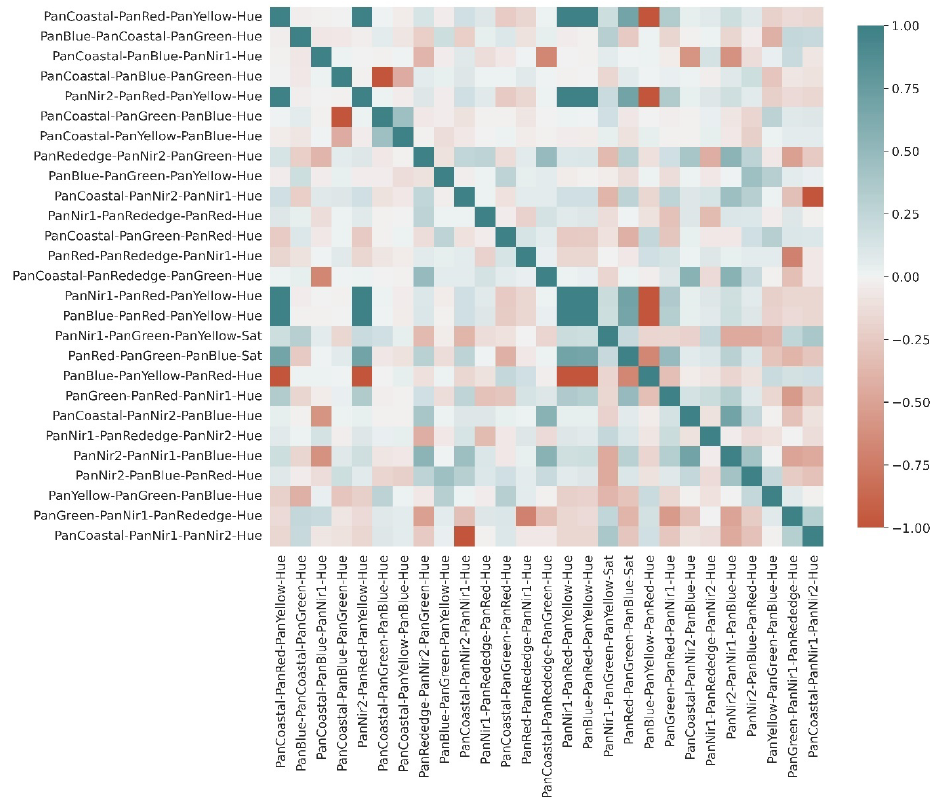
Figure 4. Correlation matrix plot of the 27 least-correlated HSV features generated from the pan- sharpened image.